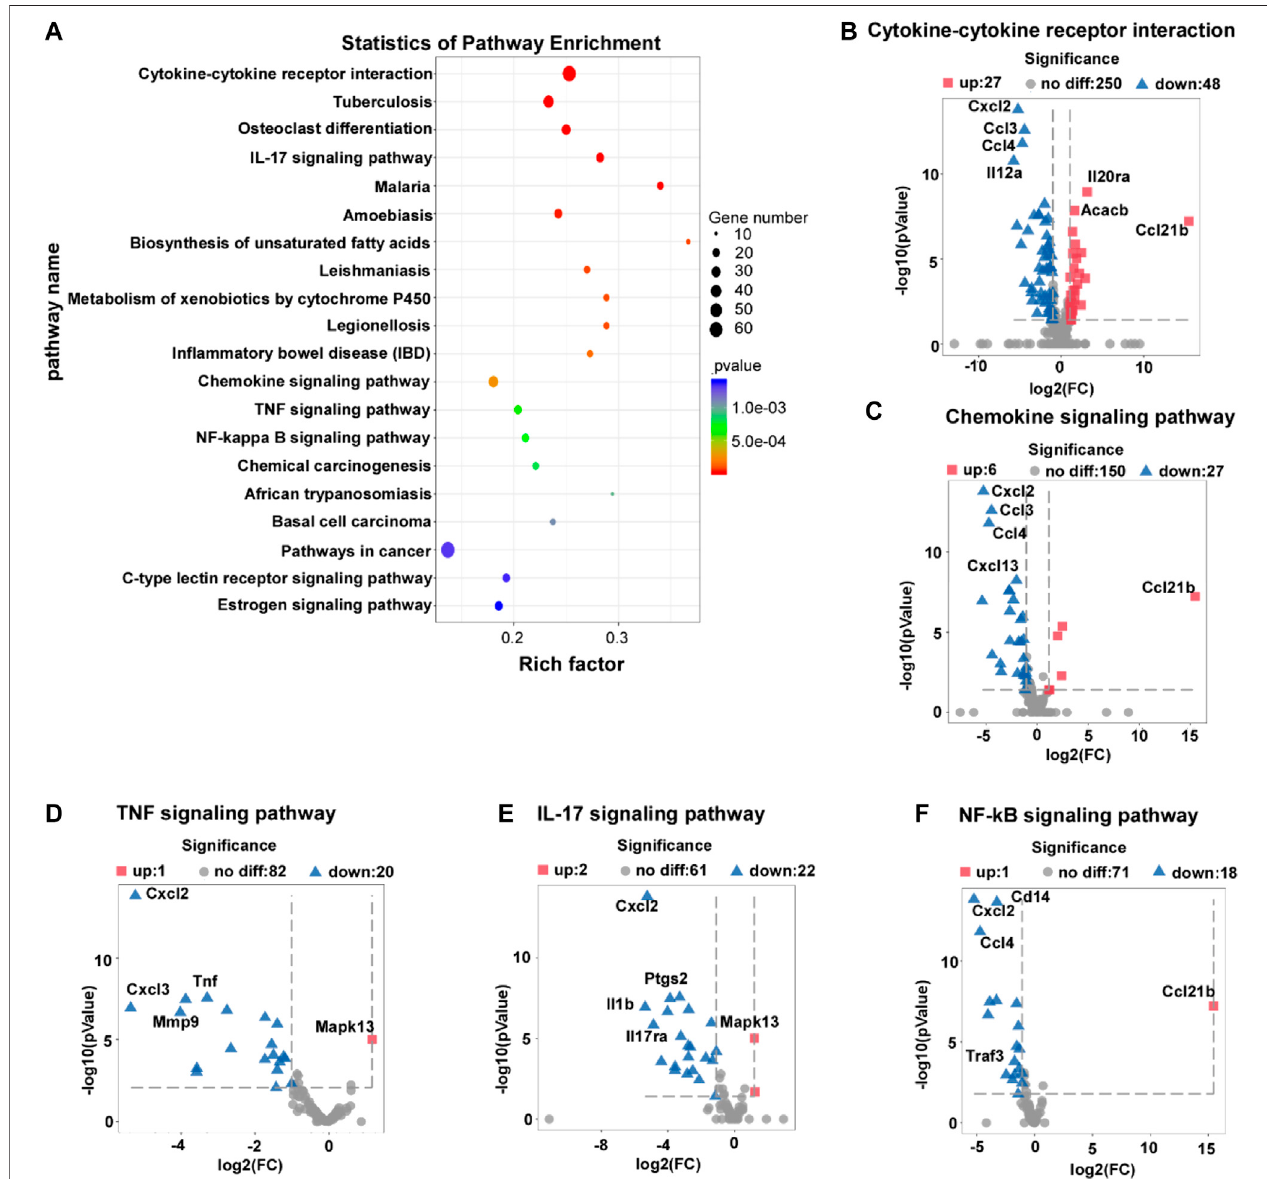
FIGURE 5 | L-THE treatment regulates the expression of cytokine-cytokine receptor interaction, chemokine signaling pathway, and IL-17A signaling pathway associated genes. (A) Scatter plot for KEGG analysis based on RNA-seq data from IMQ-induced psoriasis mice treated with 100 mM L-THE or H2O for 5 days. (B – F) Volcano plot showed the expression of cytokine-cytokine receptor interaction (B) , chemokine signaling pathway (C) , TNF signaling pathway (D) , IL-17A signaling pathway (E) , and NF- κ B signaling pathway associated genes.